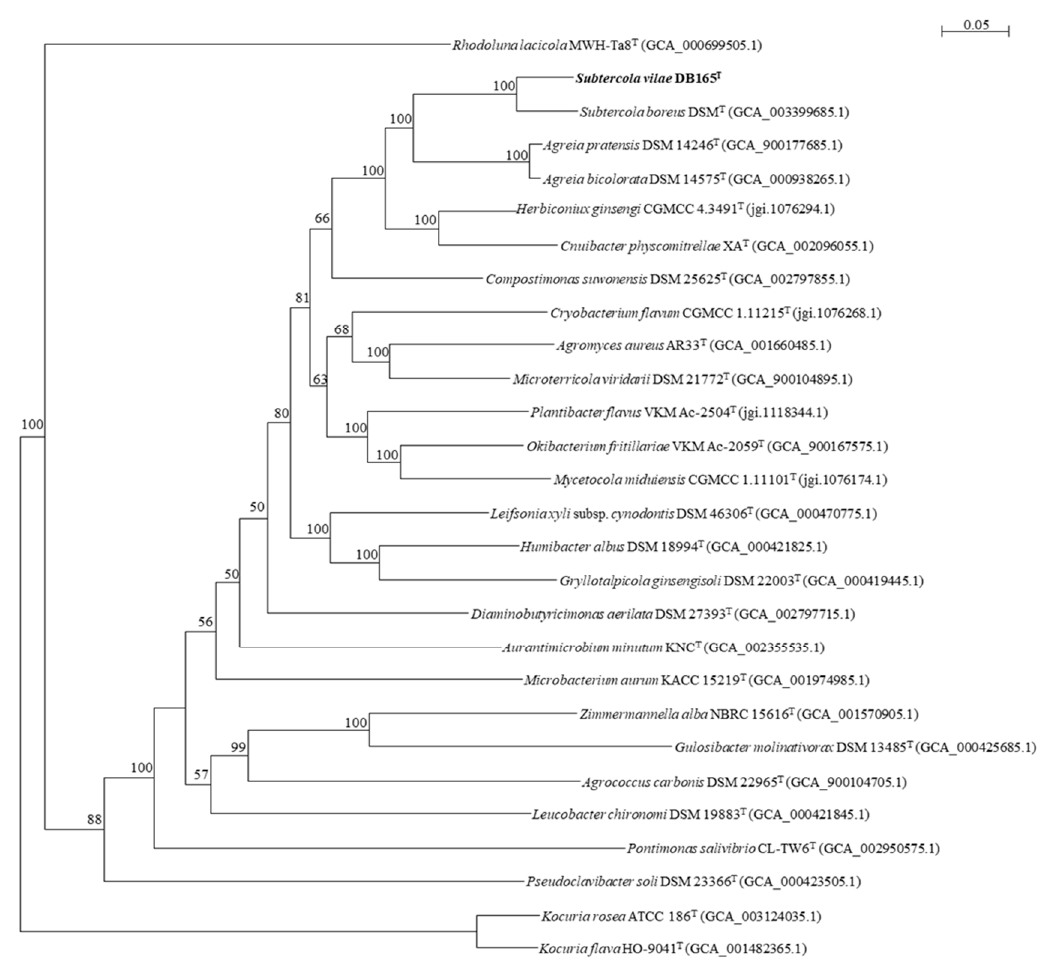
Figure 2. Maximum-likelihood tree based on 107 essential single-copy genes (amino acids) of Subtercola vilae DB165 T and Microbacteriaceae -type strains, and two Kocuria -type strains as outgroup with 1000 bootstraps. Project accession is indicated in brackets. Bootstrap values > 50% are indicated. Bar indicates 0.05 amino acids substitutions per site.